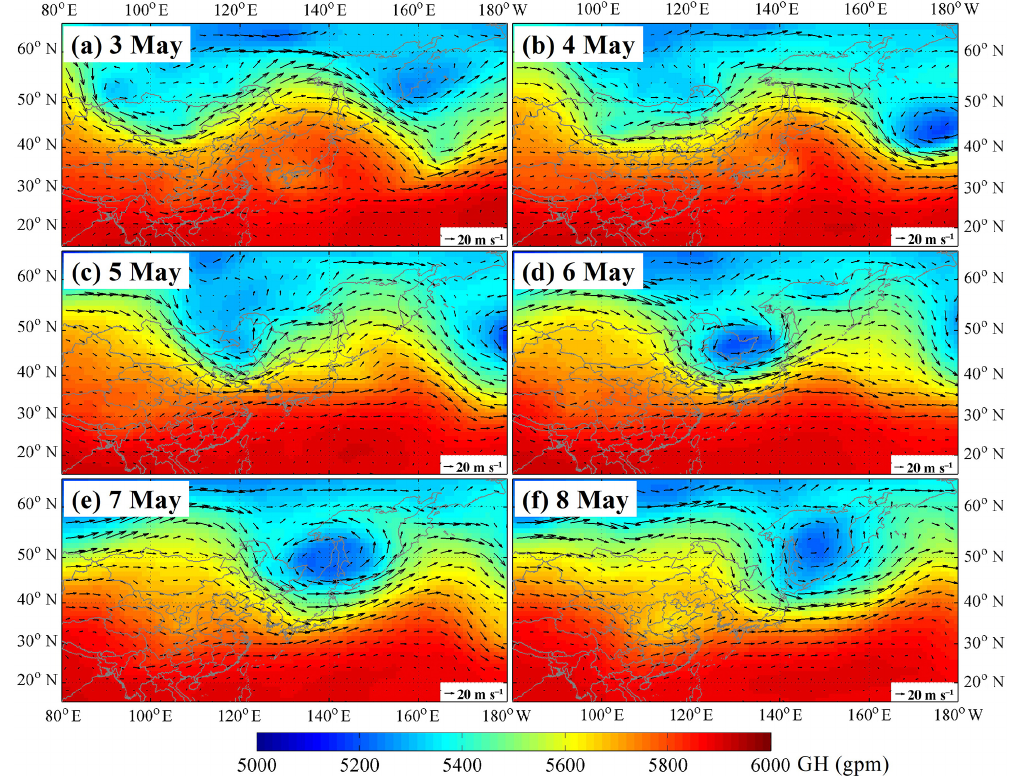
Figure 3. (a) – (f) Spatial distribution of wind vectors and geopotential height (GH) at the 500hPa level at 06:00UTC during 3–8 May. The GH and wind vectors were derived from the ECMWF ERA-Interim reanalysis